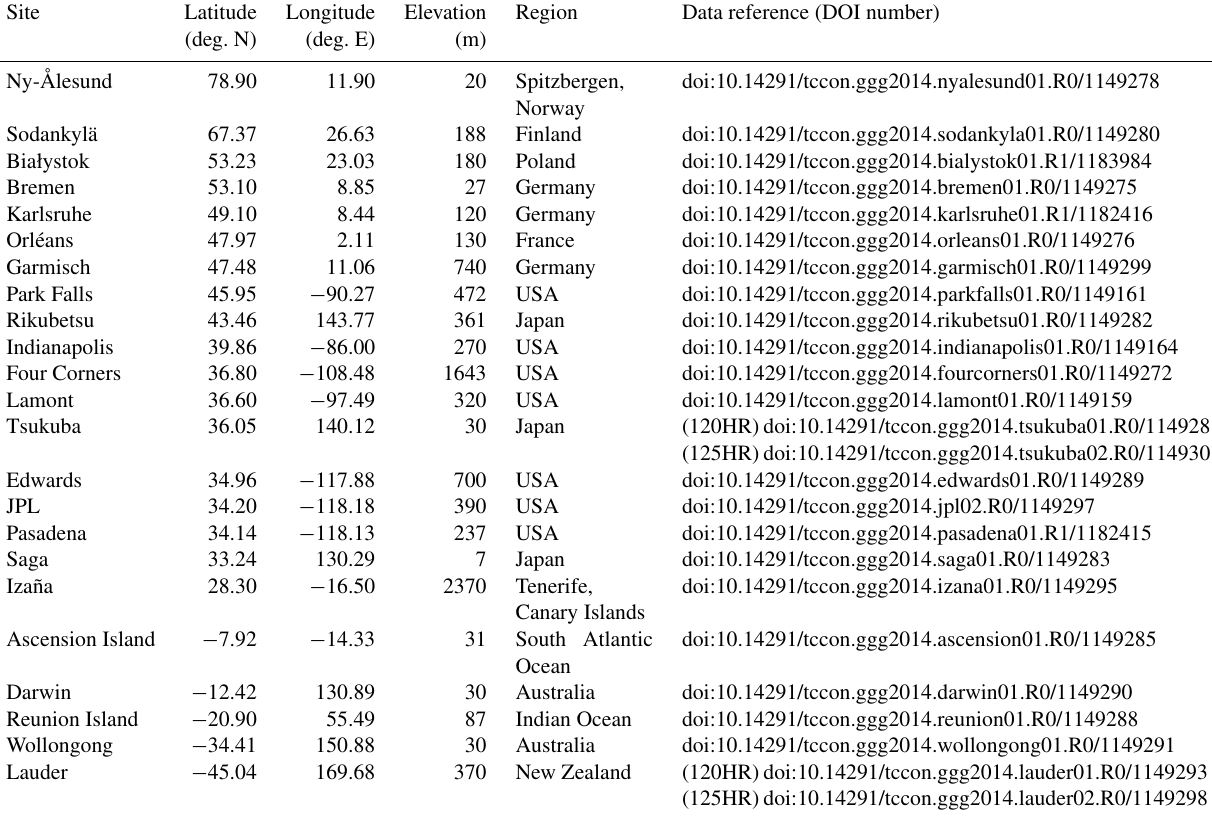
Table 1. Basic information on the TCCON sites used for correction and validation of the GOSAT data. Site Latitude Longitude Elevation Region Data reference (DOI number) (deg.